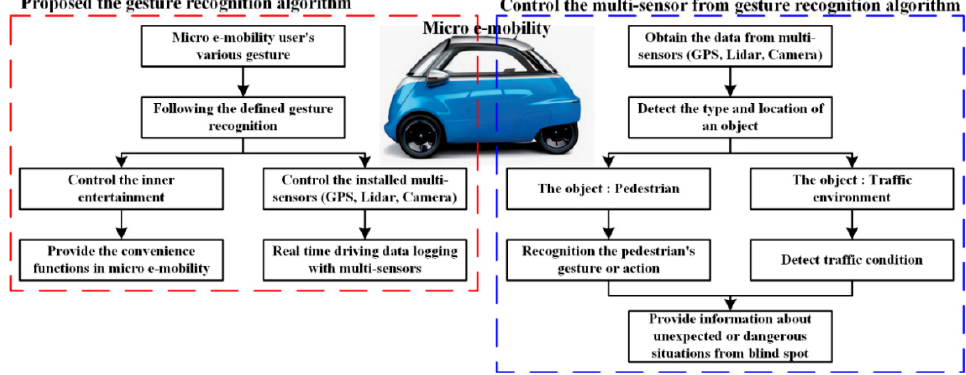
Figure 4. Conceptual diagram of the proposed system.